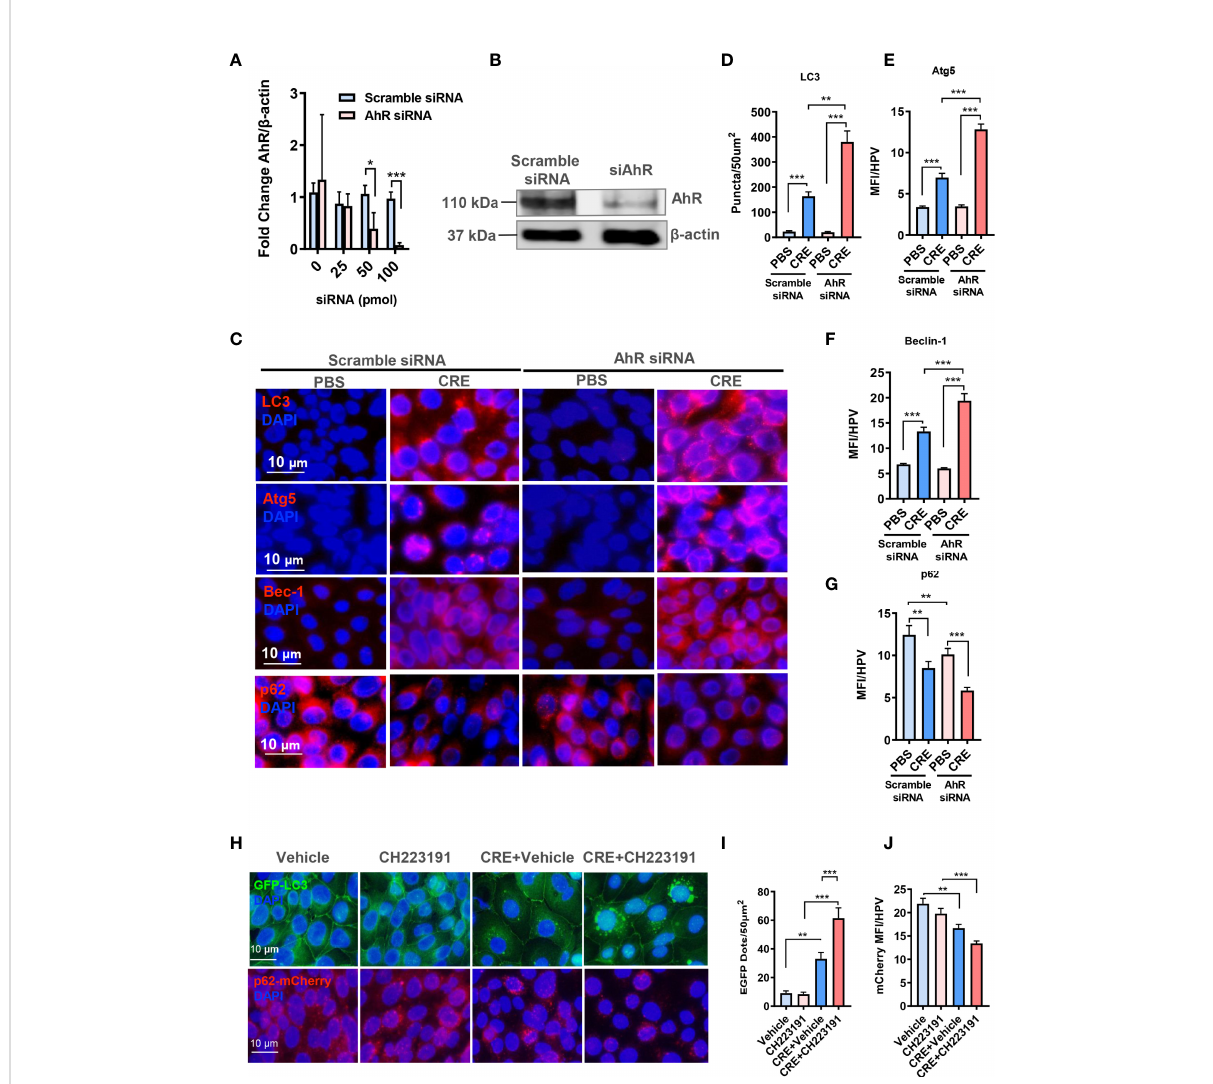
FIGURE 4 Aryl hydrocarbon receptor modulates allergen-induced autophagy in human bronchial epithelial cells (HBECs). (A) RT-PCR con fi rmation of AhR knockdown in HBECs by using different doses of AhR siRNA. (B) AhR knockdown in HBECs with 100-pmol AhR siRNA was further con fi rmed by Western blot. (C) Representative images of immuno fl uorescence staining of autophagy-related genes in HBECs with or without AhR knockdown. n = 6. (D – G) Quanti fi cation of immuno fl uorescence staining for autophagy-related genes LC3 (D) , Atg5 (E) , Beclin-1 (F) , and p62 (G) in HBECs with or without AhR knockdown. n = 12. (H) Representative immuno fl uorescence images of CRE-treated HBECs expressing GFP- LC3 or p62-mCherry in the presence or absence of AhR antagonist CH223191. (I) Quantitative analysis of autophagic fl ux according to the number of LC3 puncta (GFP dots/50 µm 2 ). (J) Quantitative analysis of p62-mCherry fl orescent signal in (H) . n = 12 [four different high-power fi elds (hpfs) of three independent experiments]. Data represent means ± SEM. * p < 0.05, ** p < 0.01, and *** p <